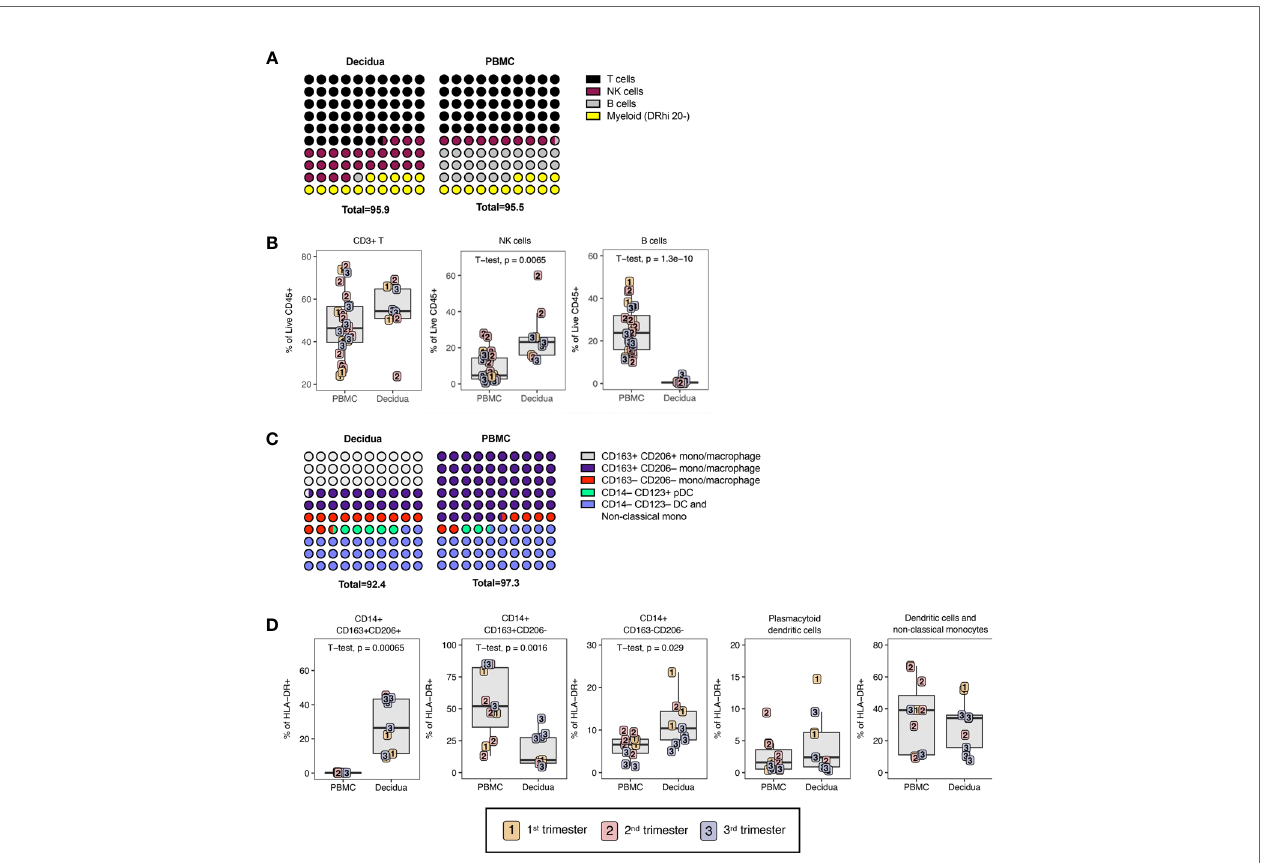
FIGURE 2 | Leukocyte composition of PBMC and decidua in normal rhesus macaques. (A) Comparison of relative proportions of the CD45+ leukocytes in decidua and PBMC. (B) Frequency of total T lymphocytes, NK cells, and B lymphocytes in PBMC and decidua during the fi rst (yellow), second (red) and third trimester (blue) of pregnancy in normal rhesus macaques. (C) Comparison of relative proportions of the myeloid cells (CD3-CD20-HLA-DR+) in decidua and PBMC. (D) Frequency of myeloid cells (CD3-CD20-HLA-DR+) in PBMC and decidua of monocyte/macrophages subsets, and dendritic cells (DC). P-values <0.05 (unpaired t-test) shown on the